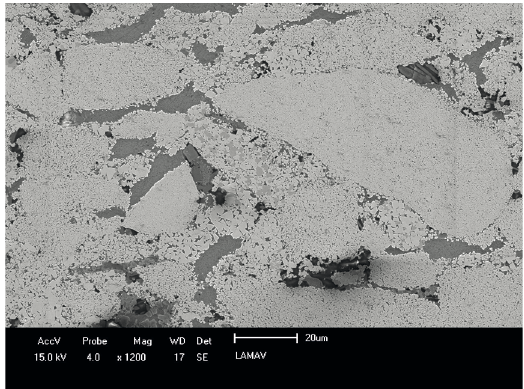
Figure 6. Structure of alloy REC. The matching of the contours of WC-Co and Co particles is